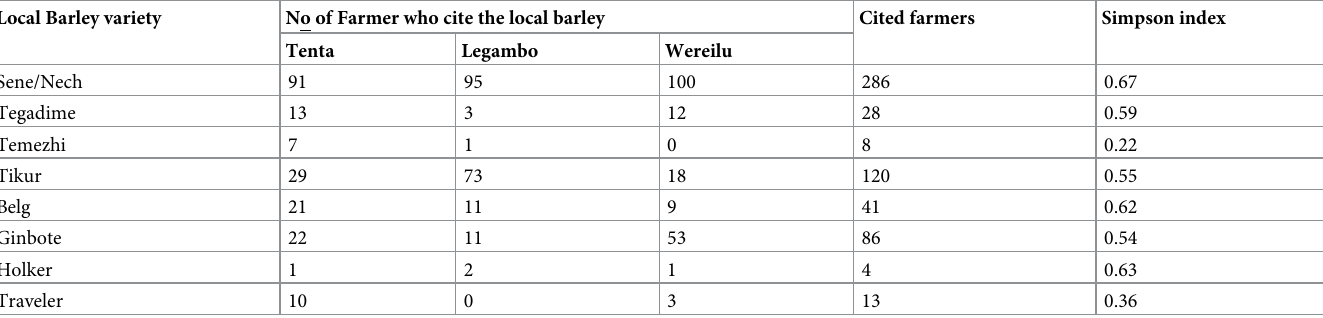
Table 2. Occurrence of local barley varieties in the three districts according to Simpson’s